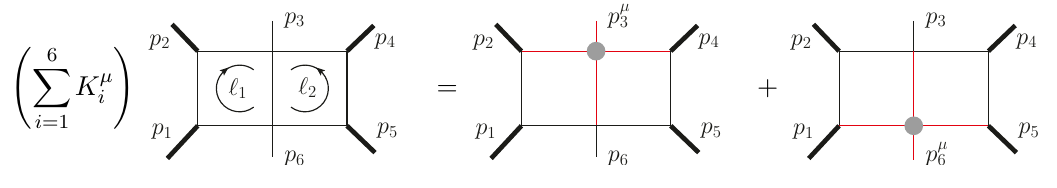
Figure 6 . Conformal Ward identity for the 4D double box. We act with K (cid:22) on the on-shell legs p 3 , p 6 , and with K (cid:22) on the o(cid:11)-shell legs p 1 , p 2 , p 4 , p 5 (cid:1)=2